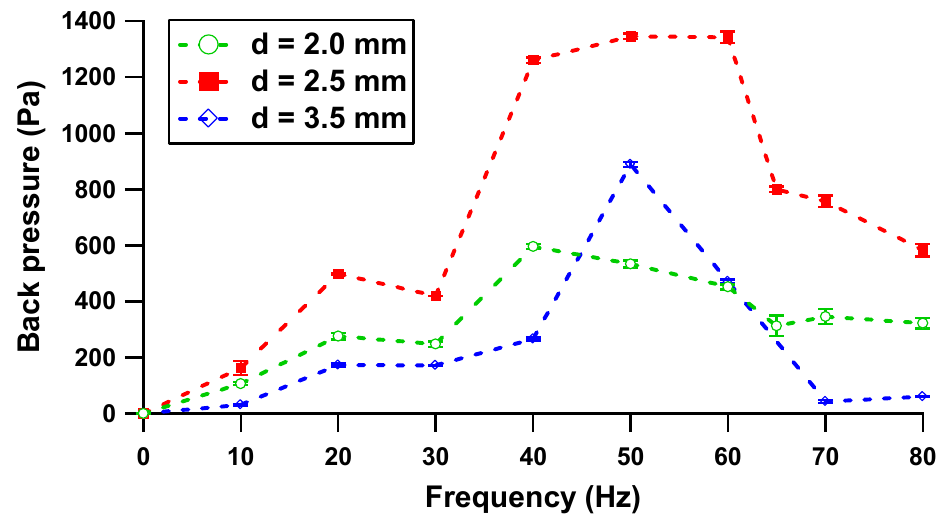
Figure 12. Back pressure vs.